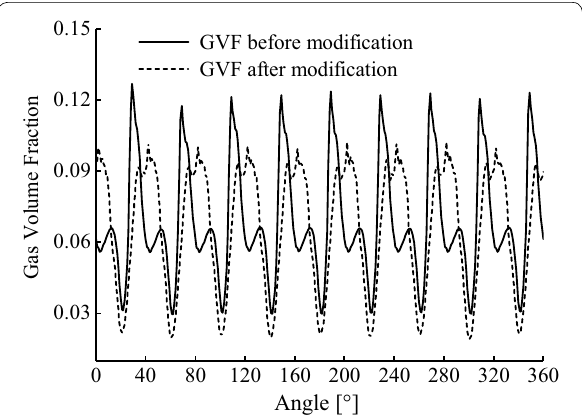
Figure 18 Comparison of GVF at observation points with and without structure